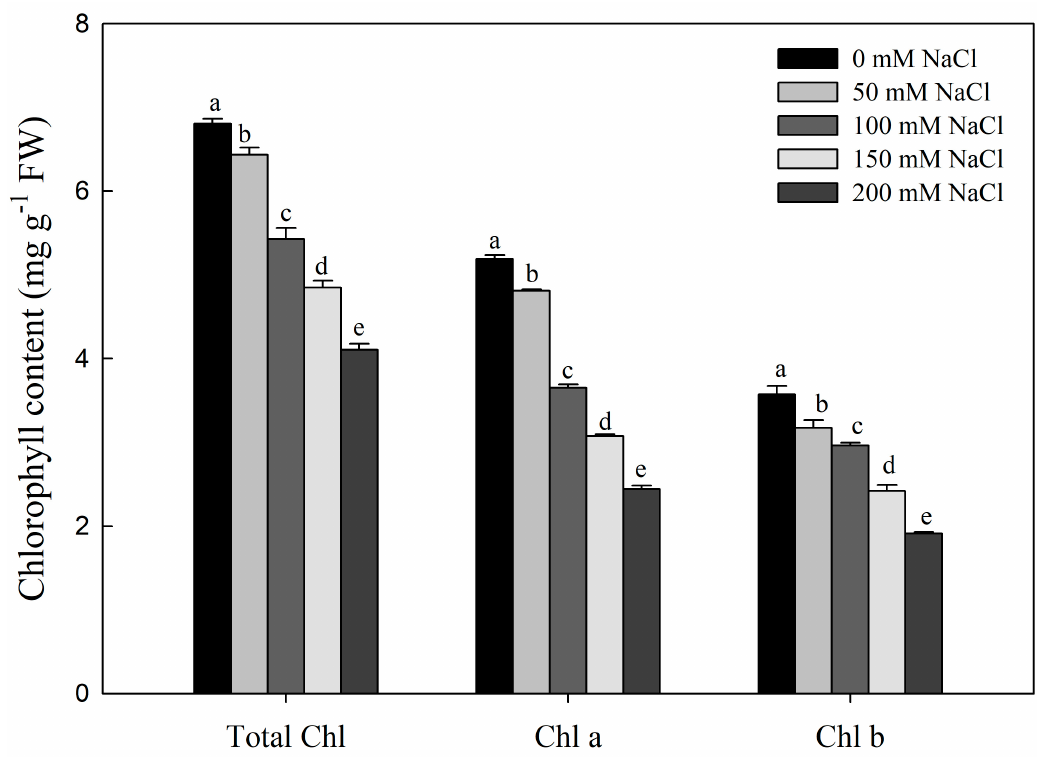
Figure 7. Effect of NaCl stress on the content of total chlorophyll, chlorophyll a, and chlorophyll b in R. pseudoacacia seedlings. Values are mean ± SD of five biological replicates. Bars with different letters are significantly different at p < 0.05 according to Duncan’s multiple range tests.